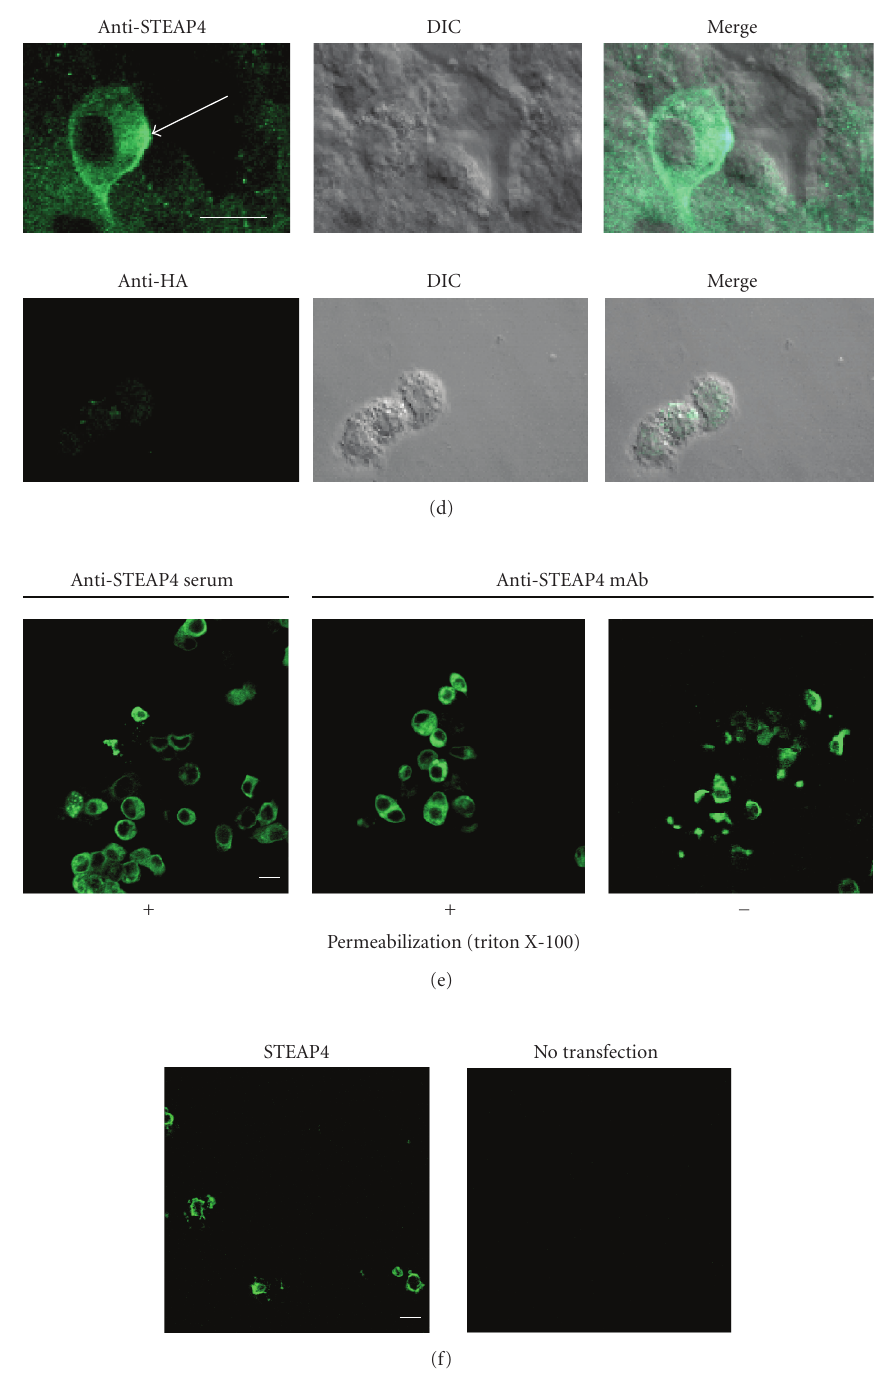
Figure 2: hSTEAP4 immunization. (a) Flow cytometry analysis to detect anti-hSTEAP4 in sera from immunized mice. 293T cells transiently transfected with pMRX-hSTEAP4-IRES-GFP were stained with sera, followed by PE conjugated antimouse IgG. (b) Specific binding of anti-STEAP antibody in flow cytometry analysis. The upper panels show 293T cells transfected with pMRX-hSTEAP1-IRES-GFP. The lower panels show 293T cells transfected with pCAGGS-hSTEAP4-IRES-GFP. The cells were reacted with the indicated serum and stained with PE conjugated antimouse IgG. (c) Detection of hSTEAP4 expression in LNCaP cells using flow cytometry analysis. For androgen treatment, LNCaP cells were cultured with 5-DHT (10 − 9 M) for 24 hours. (d) hSTEAP4 expression in androgen stimulated LNCaP cells using immunofluorescent staining. Arrow indicates a stained cell. Scale bar = 20 μ m. (e) hSTEAP4 proteins detected by anti-hSTEAP4 monoclonal antibody (4F2; IgG2a) in 293T cells transfected with pCAGGS-hSTEAP4. Scale bar = 20 μ m. (f) Anti-hSTEAP4 monoclonal antibody bound to hSTEAP4 proteins on cell surface. The antibody (4F2) was added to 293T cells transfected with pCAGGS-hSTEAP4 and the cells continued to be cultured for 30 minutes. The cells were fixed and reacted with FITC conjugated antimouse IgG. Scale bar = 20 μ